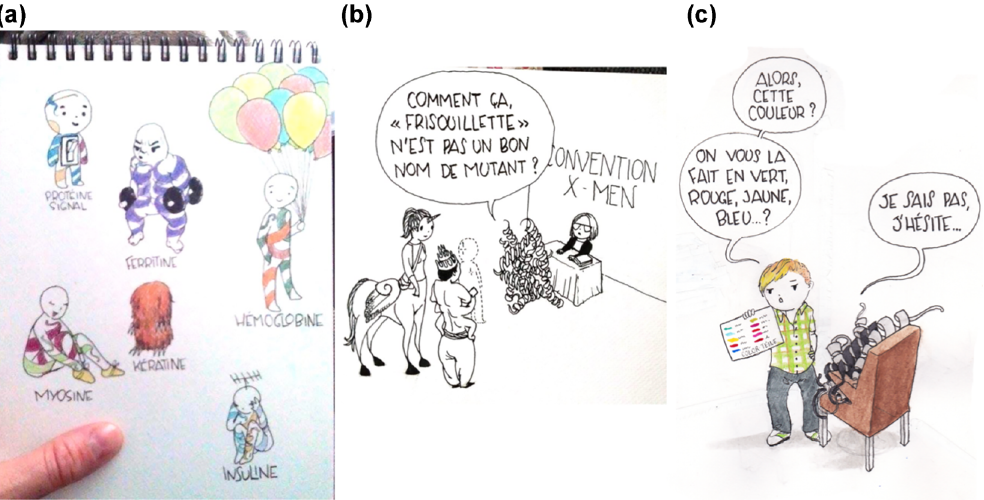
Figure 5: Early sketches by Anmryn for the protein figures. (a) Humanoid figures showing the function of proteins (e.g., hemoglobin, right, carries around a couple of balloons). (b) A mutant protein trying to join the X-Men team. (c) A protein that chooses the colour of its GFP tags at the hairdresser.